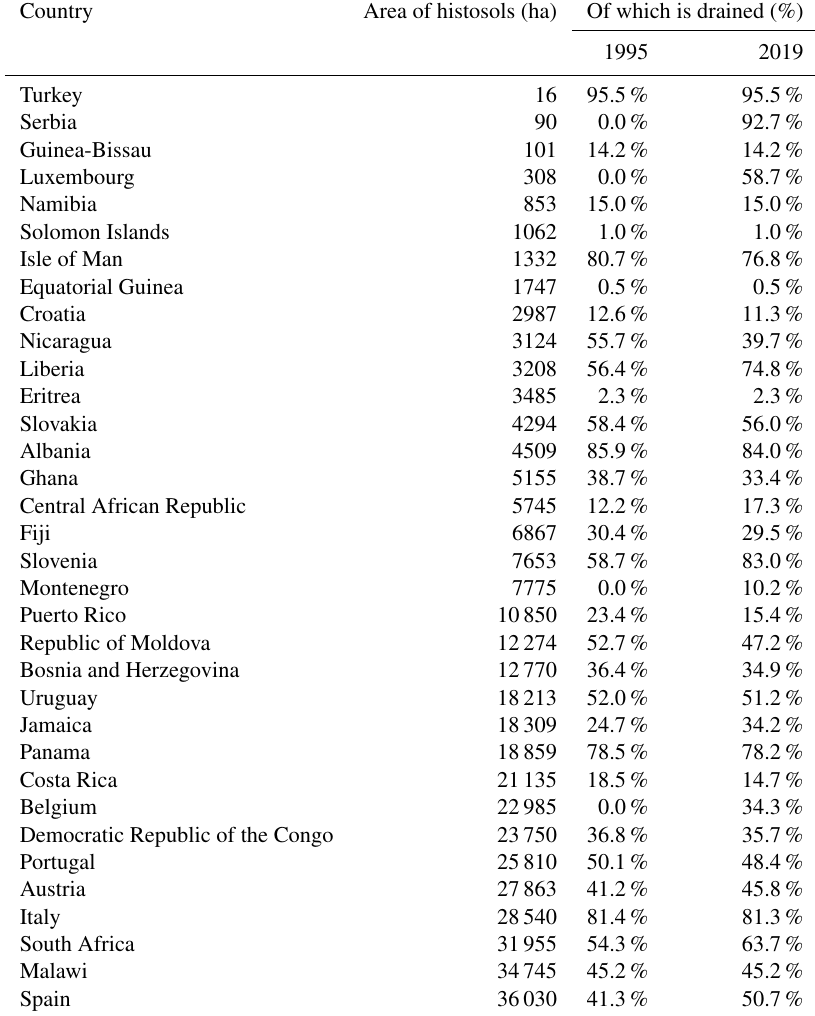
Table A2. Original area of histosols and share of drained histosols in 1995 ∗ and 2019. Country Area of histosols (ha)